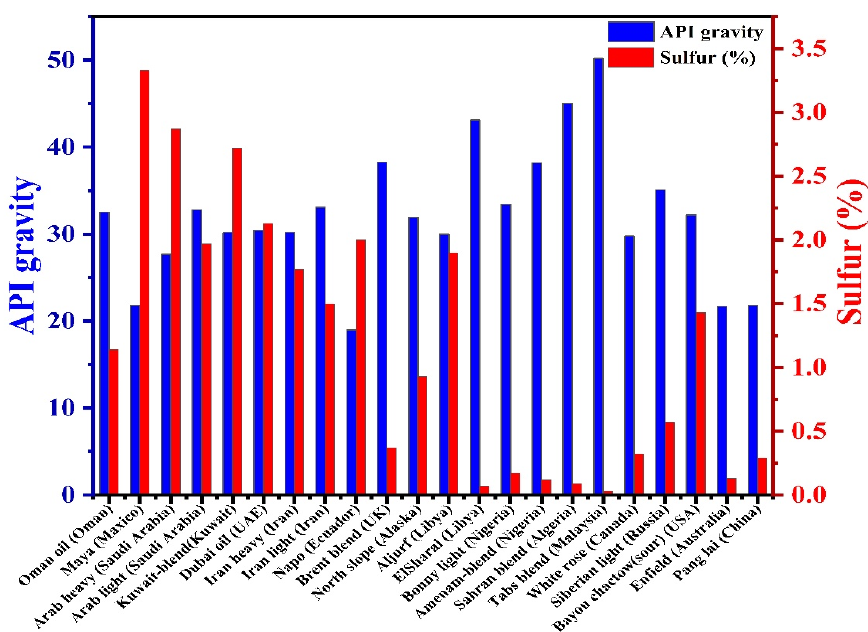
Figure 1. API gravity and sulfur content of selected crude oils.